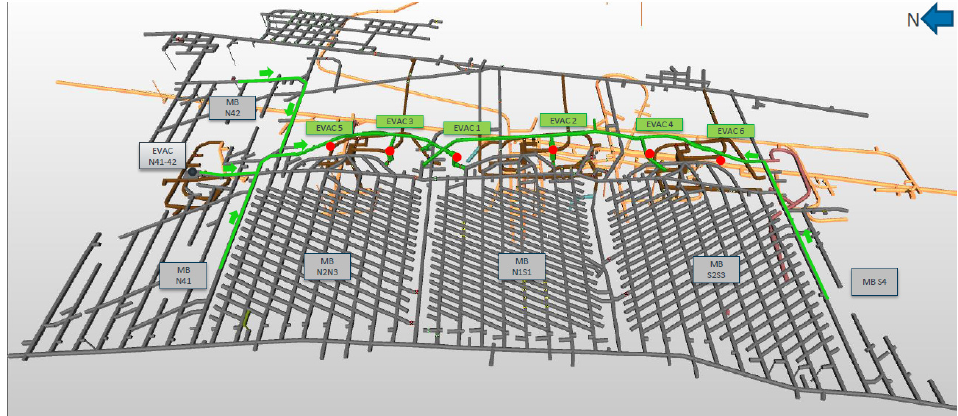
Figure 4. Macroblocks development in level 1, Chuquicamata underground mine [47].